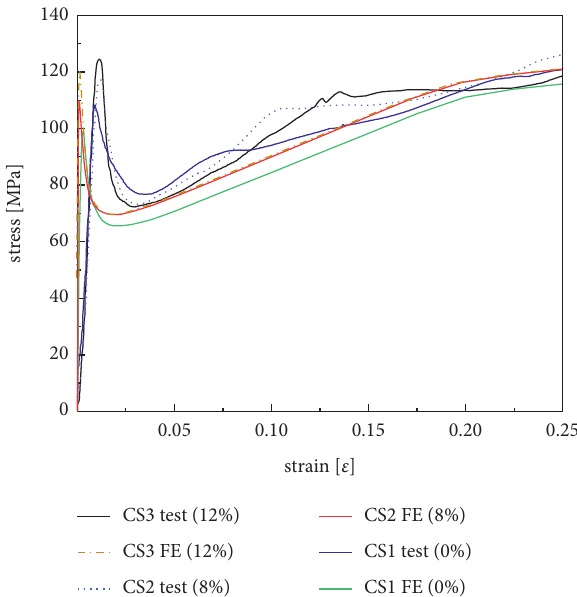
Figure 6: Stress-strain curves of different expansive.